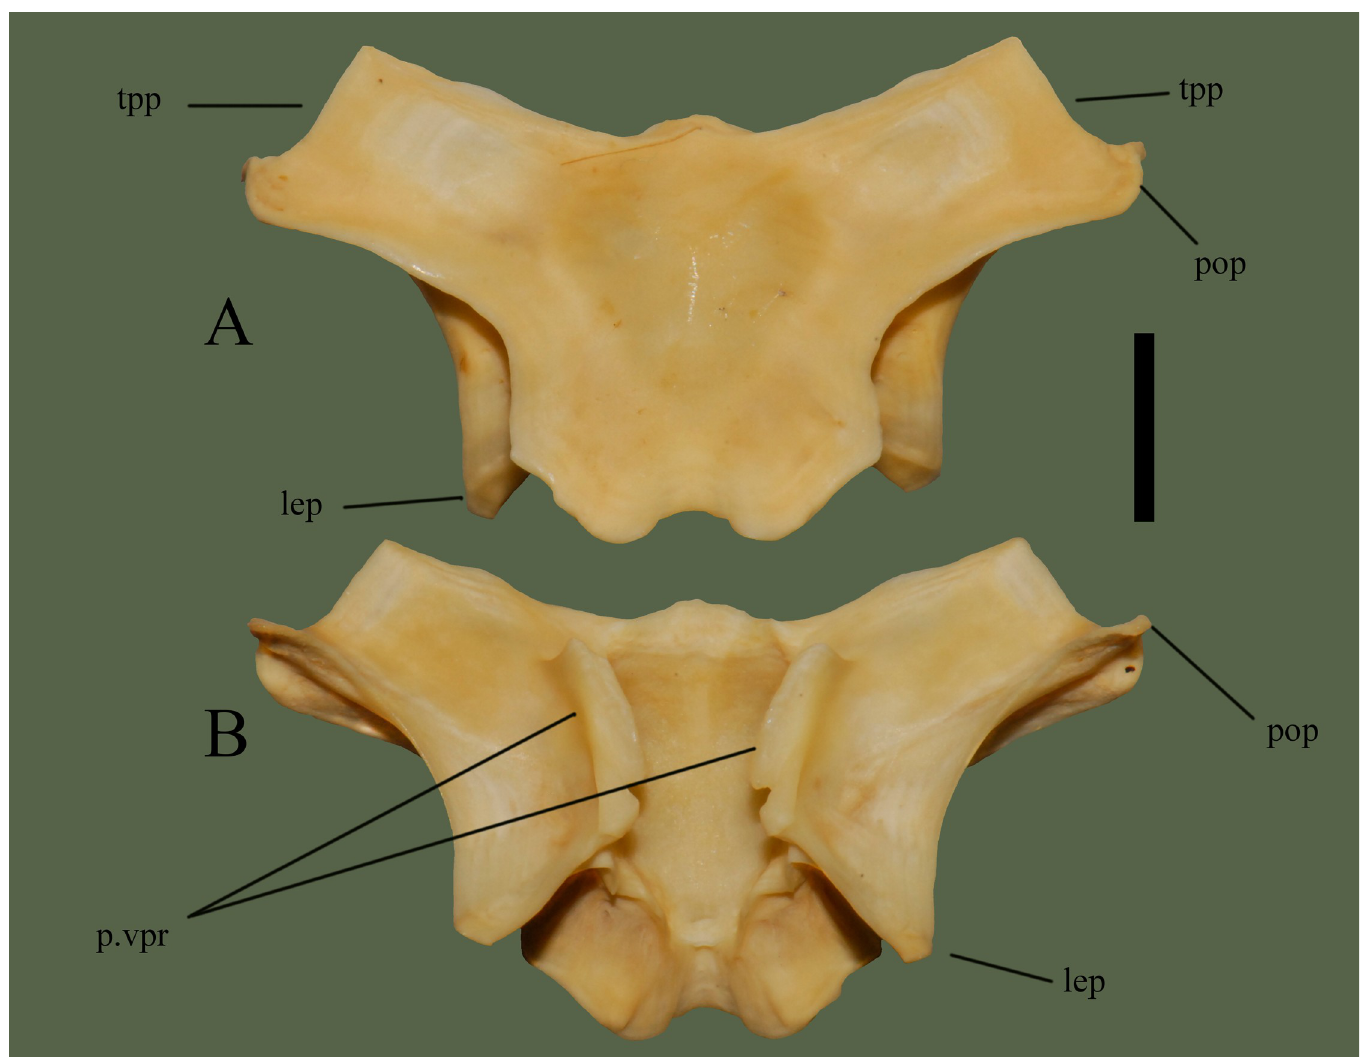
Fig 11. Parietal (ETVP 3295) in dorsal (A) and ventral (B). Anterior is to the top. Scale bar = 5 mm. Abbreviations: p.vpr = parietal ventral process; lep = lateral extension of parietal; pop = postorbital process of parietal; tpp = transverse process of